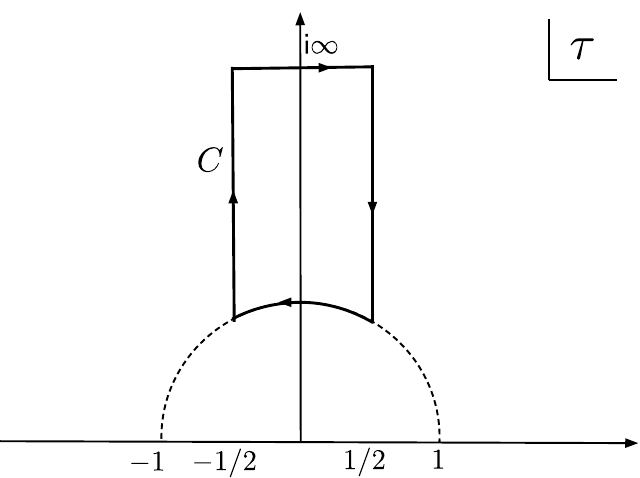
Figure 3 . An integration contour C in the τ -plane. It encloses the fundamental region of the SL(2 , Z )